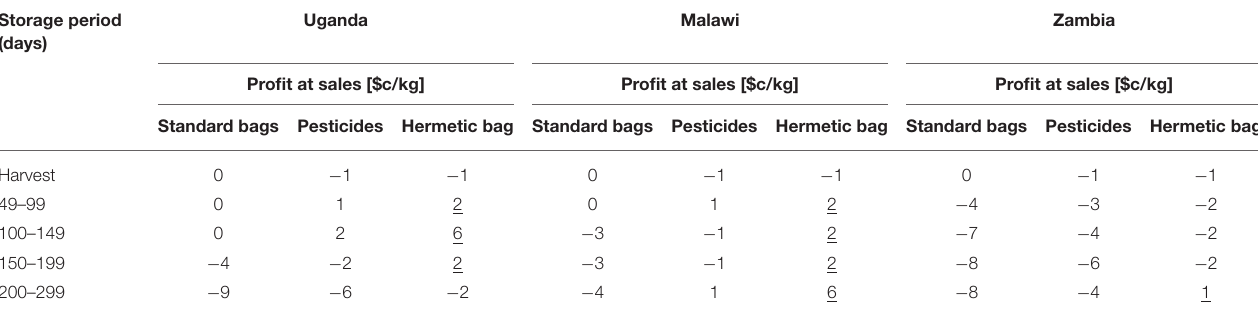
TABLE 7 | Calculated profit for farmer selling their maize during storage with different types of storage methods and in different African countries with a bag lifespan of 3 years. Storage period Uganda Malawi (days)